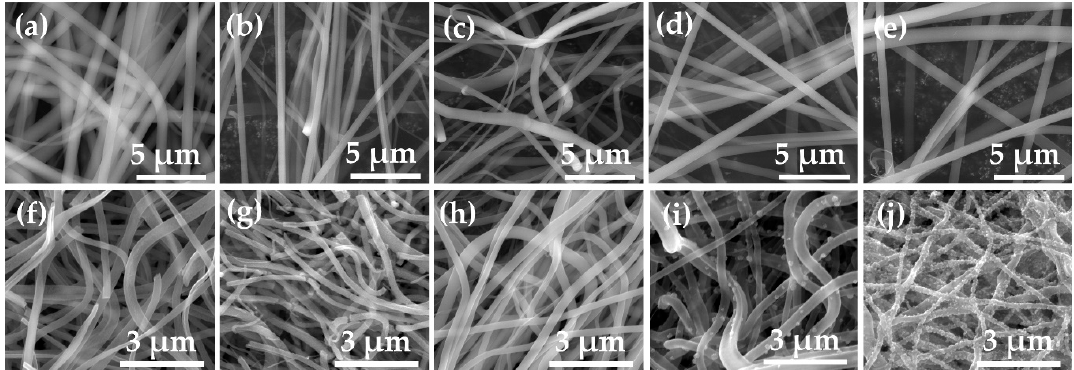
Figure 3. Field emission scanning electron microscope (FE-SEM) images of as-spun nanofibers with different molar ratios of Ti and Zn (( a ): TZ1, ( b ): TZ2, ( c ): TZ3, ( d ): TZ4 and ( e ): TZ5) and annealed Ti–Zn complex oxide nanofibers with different molar ratios of Ti and Zn (( g ): TZ1, ( h ): TZ2, ( i ): TZ3, ( j ): TZ4 and ( k ): TZ5).